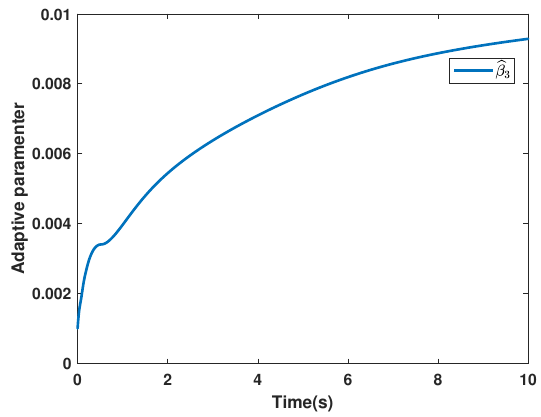
Figure 11. Adaptive parameter (cid:98) β 3 ( t ) .